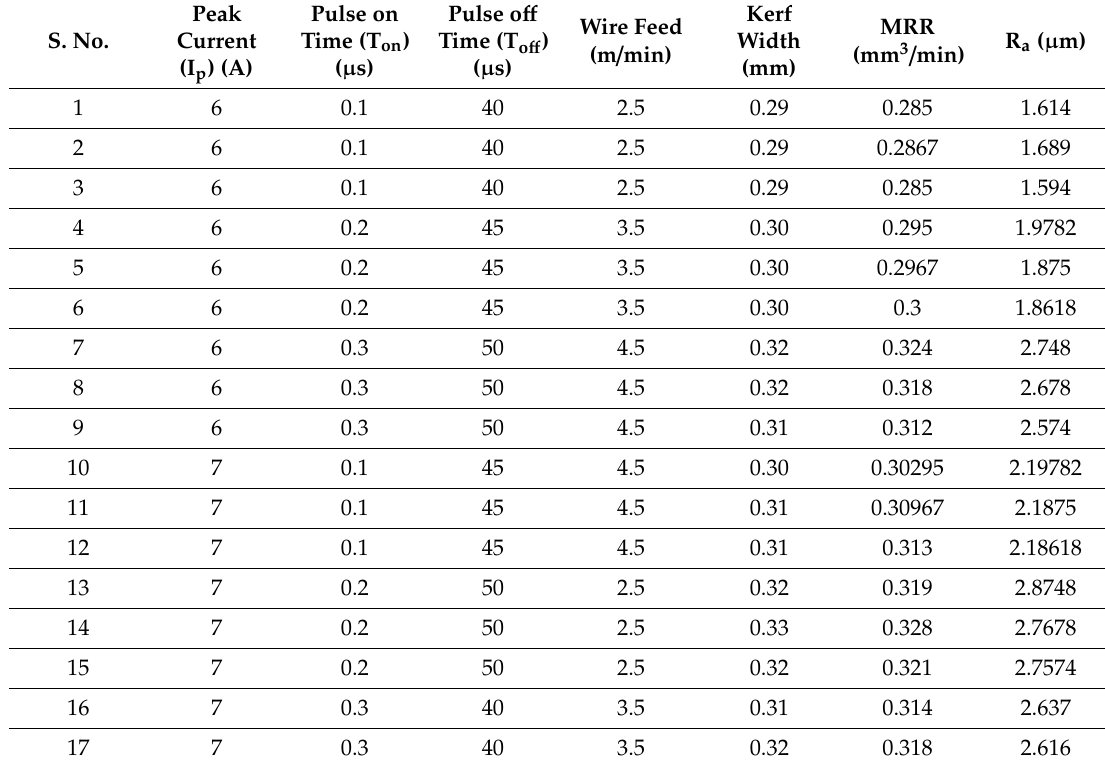
Figure 7. Processed Al-SiC-TiC metal matrix composite plates. Table 6. L 27 orthogonal array for wire electrical discharge cutting of the Al-SiC-TiC metal matrix composite under a deionized dielectric